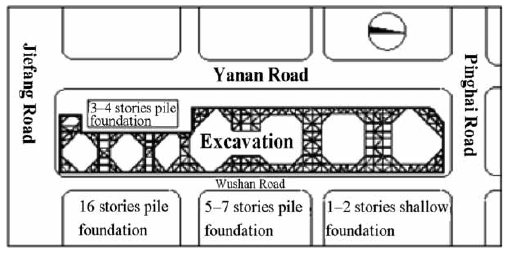
Fig. 2. Site location and surrounding conditions